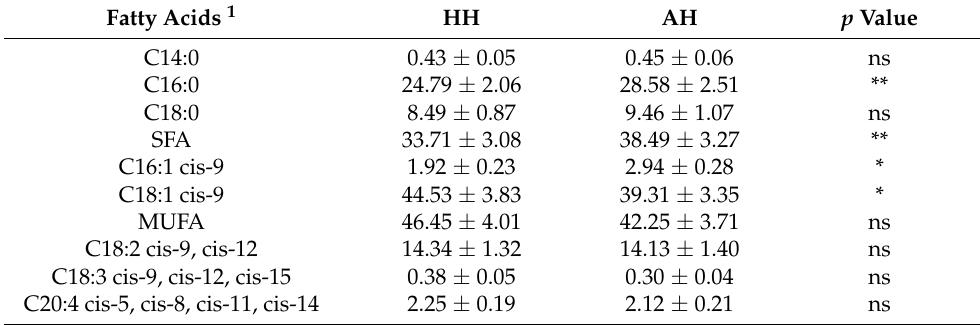
Table 4. Fatty acid profile in egg yolks obtained from commercial hybrid hen (HH) and Nera Atriana laying hen